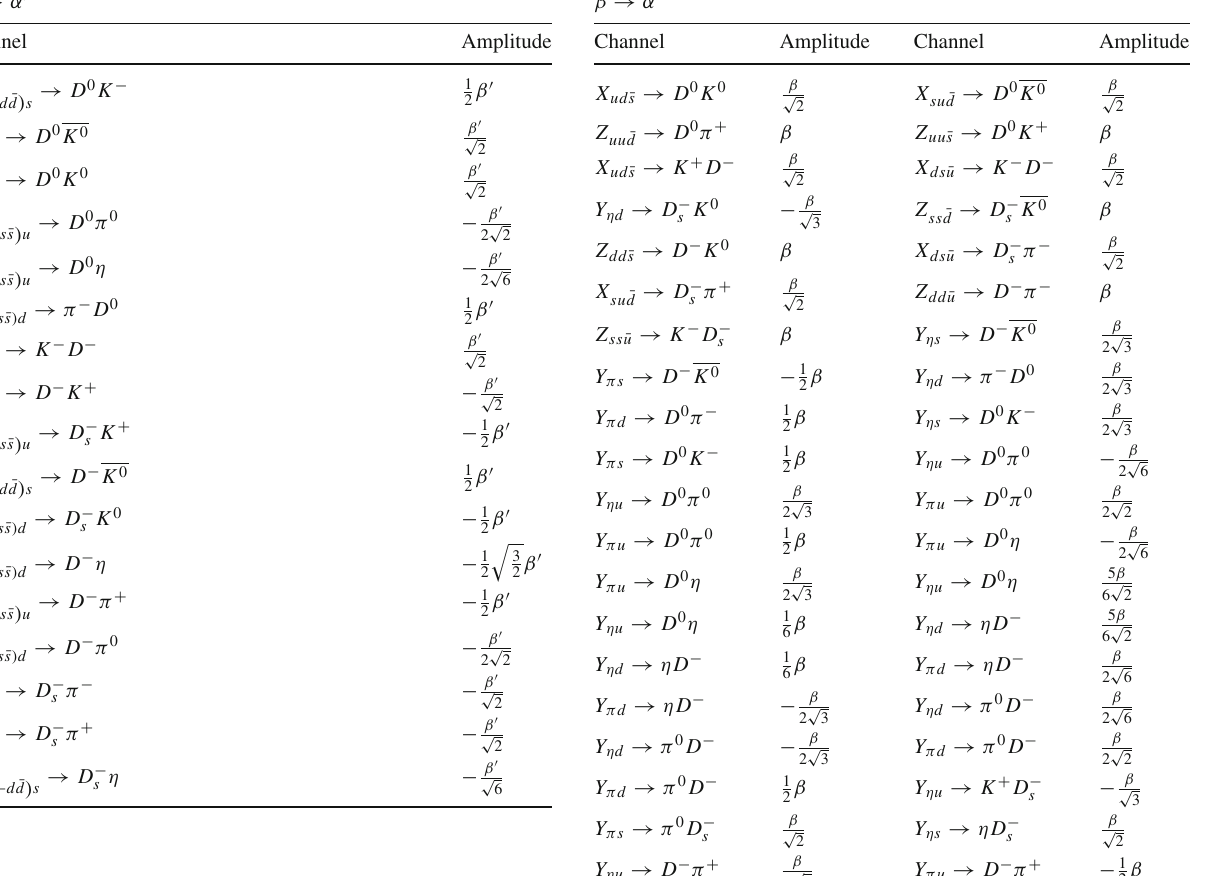
Table 4 Decay amplitudes of X c → D i P for 15 representation tetraquarks containing X 1 ( 2900 ) . The results can be easily applied